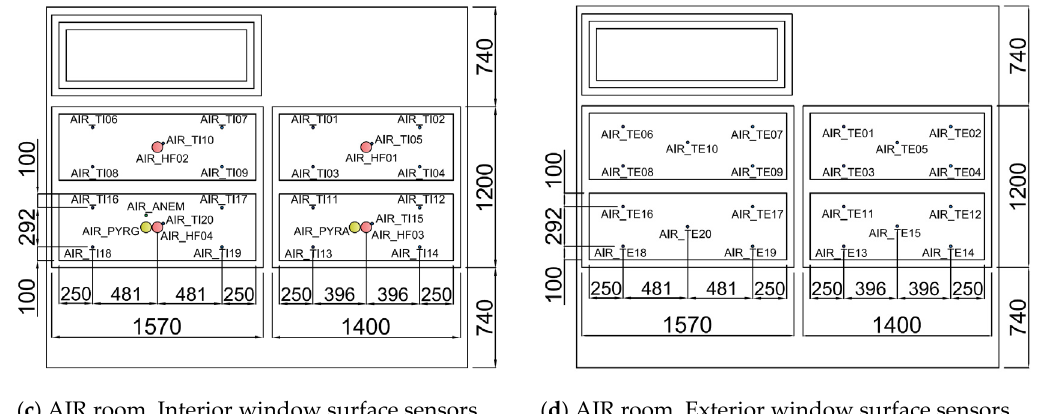
Figure 3. Sensor’s position. Dimensions in mm. TI and TE refer to thermocouples in the interior and exterior surface of the window, respectively. HF refers to heat flux sensors. ANEM refers to the anemometer. PYR and PYRA refer to the pyrgeometer and pyranometer, respectively.